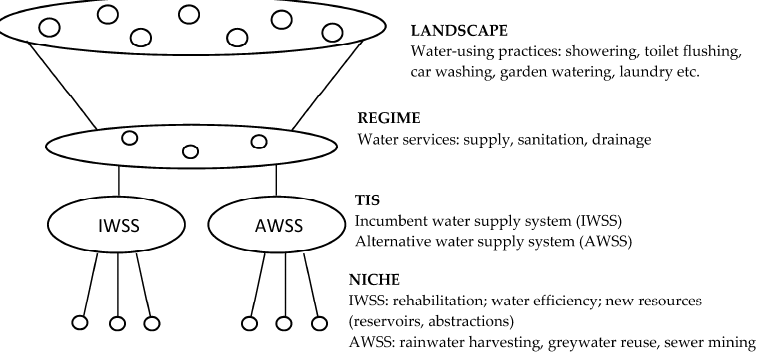
Figure 1. The multi ‐ level perspective (landscape, regime, niche) and corresponding technological innovation systems (TIS) for the water sector. innovation systems (TIS) for the water Within the MLP, socio ‐ technical niches (in this case incumbent or alternative techniques such as